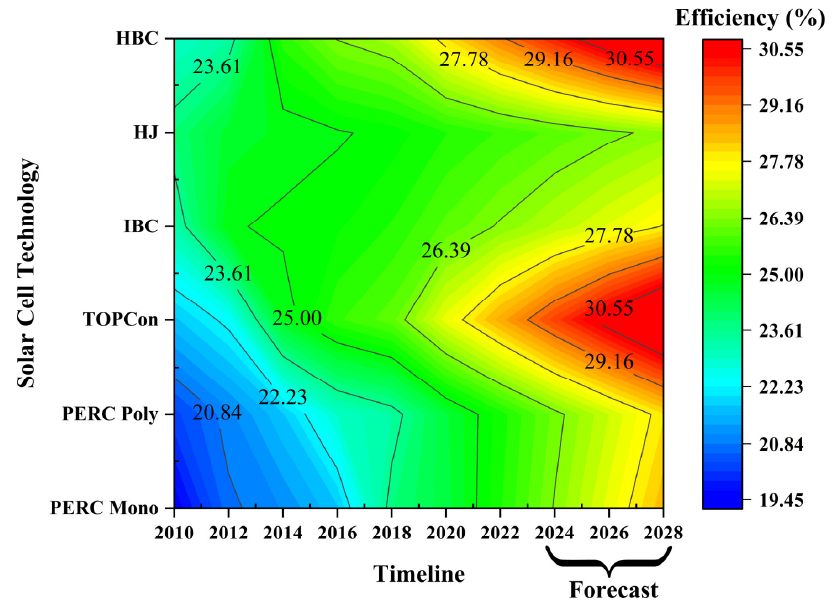
Figure 3. The efficiency progress development of various crystalline silicon solar cells technologies from years 2010 to date and expected prediction.